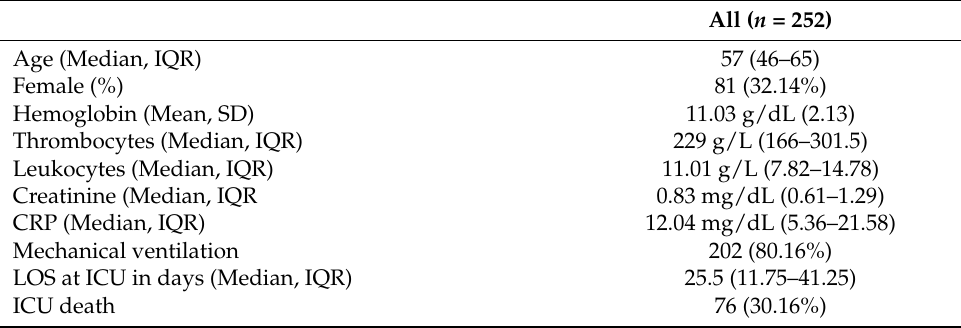
Table 2. Characteristics of all COVID-19 patients at